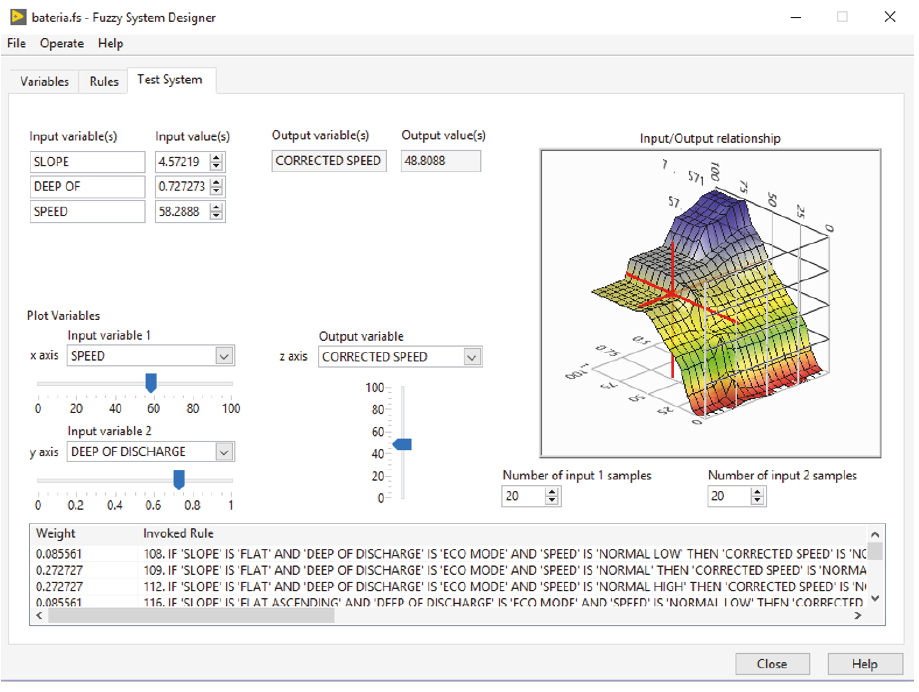
Figure 8: LabVIEW fuzzy system designer.